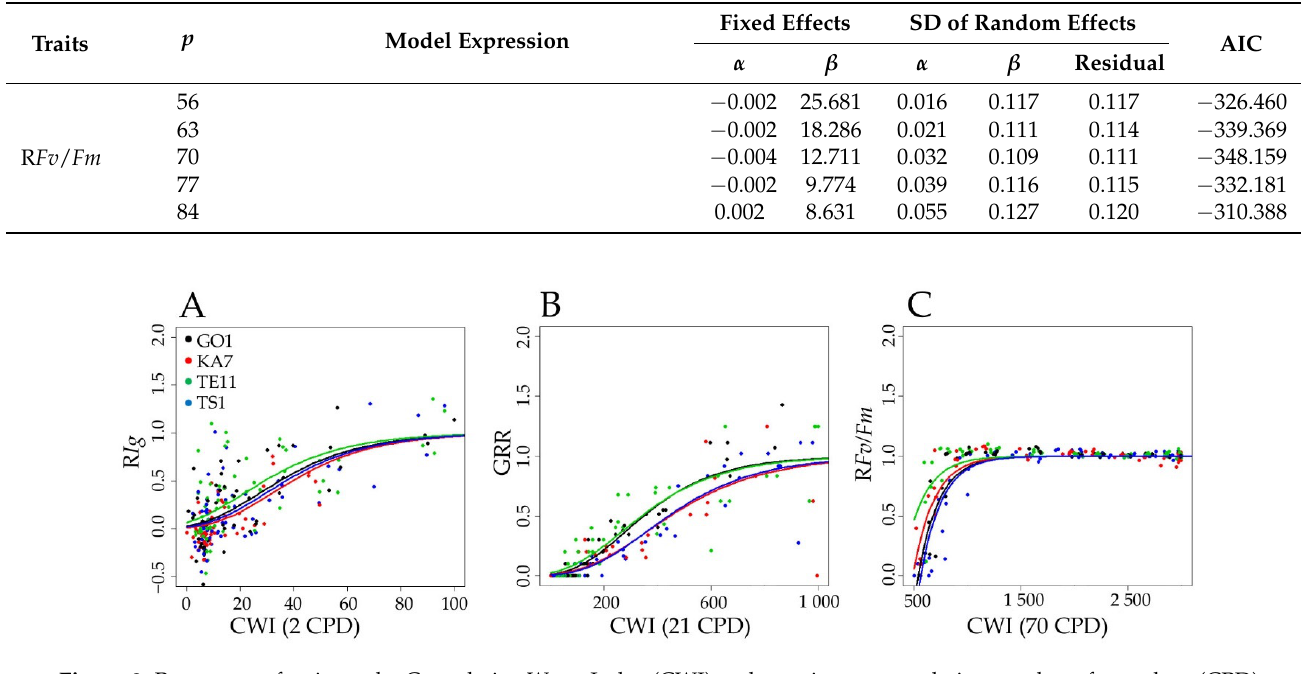
Figure 8. Responses of traits to the Cumulative Water Index (CWI) at the optimum cumulative number of past days (CPD). ( A ) Response to the CWI at 2 CPD in the stomatal conductance index ratio (R Ig ) model. ( B ) Response to the CWI at 21 CPD in the growth rate ratio (GRR) model. ( C ) Response to the CWI at 70 CPD in the maximum photochemical quantum yield of photosystem (PS) II (R Fv/Fm ) model. Data points are the measured values, and the curves are the predicted clonal response estimated by the nonlinear mixed-effect model (NLMM) fitted to the Gompertz function ( A , B ) or the von Bertalanffy function ( C ). The black, red, green, and blue symbols correspond to the clones GO1, KA7, TE11, and TS1, respectively. Table 3. Parameter estimates and variance components (VC) of the clones. The percentages of VCs are shown in parentheses, and the statistical significances of the random effects are shown as asterisks. CPD: cumulative number of past days. EstimatesofRandomEffectsin Traits CPD